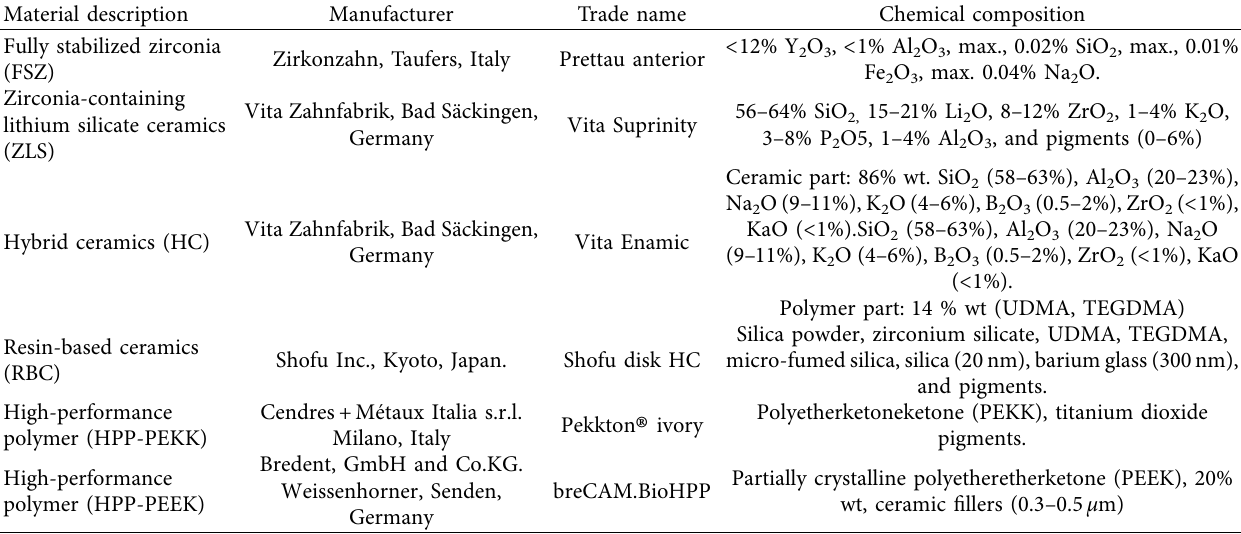
Table 1: Detailed description of materials tested in the study.